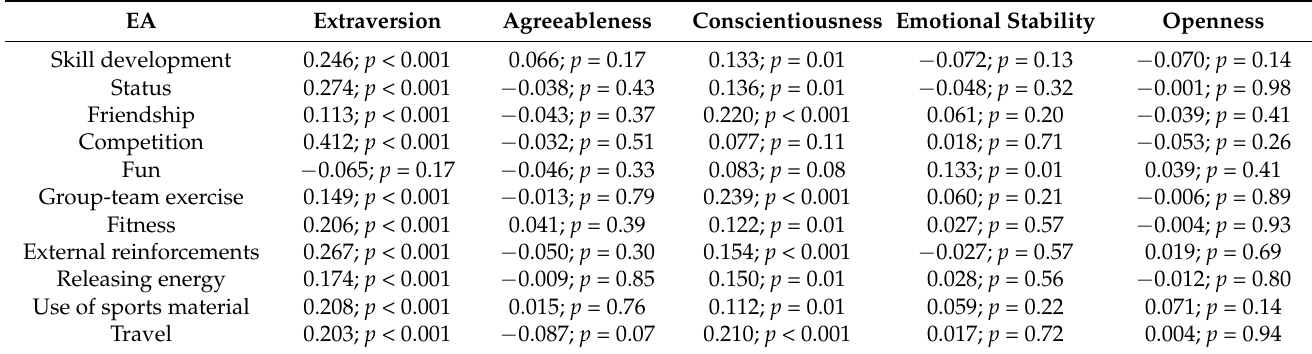
Table 5. Partial correlations among motivational factors and personality